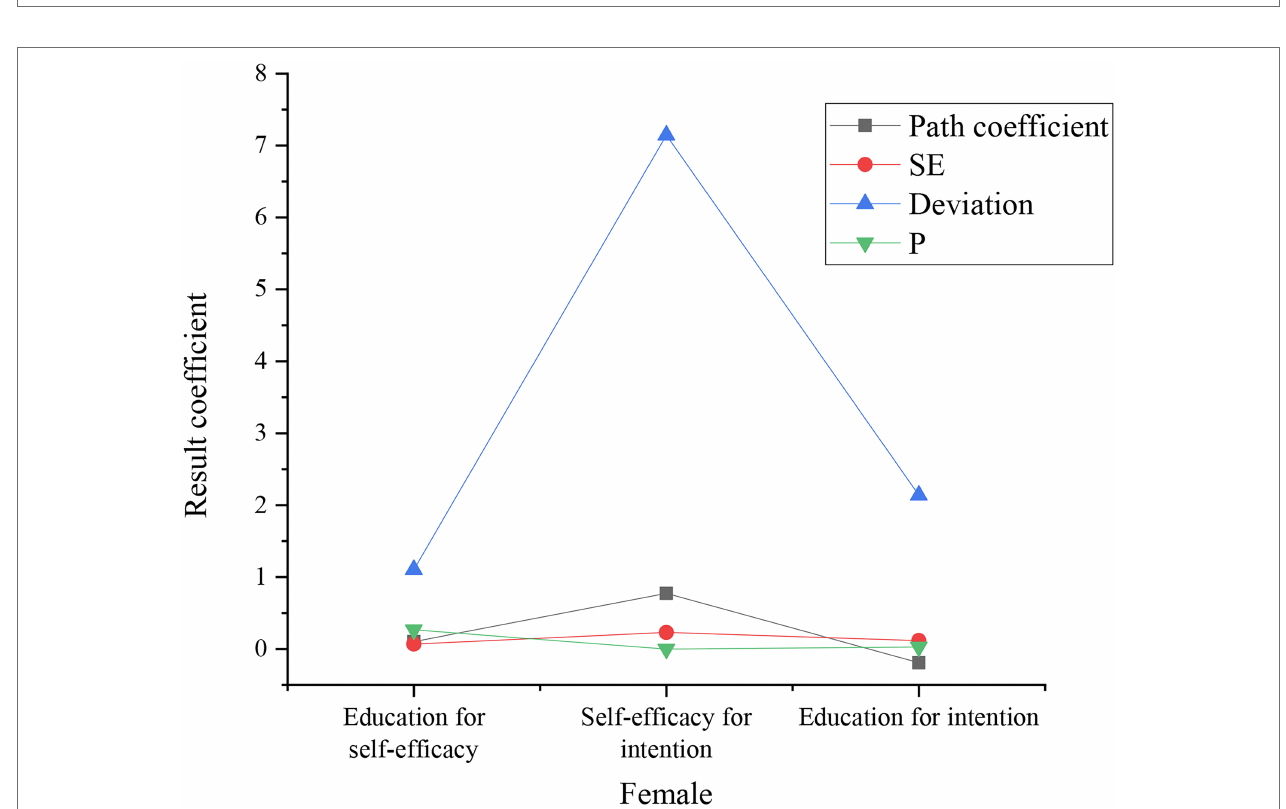
FIGURE 7 | Comparison of deviation calibration.